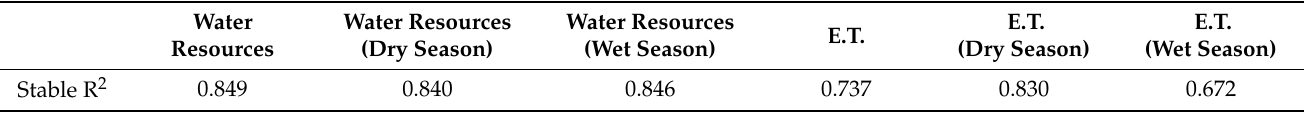
Table 4. Stable R 2 results of Holt exponential